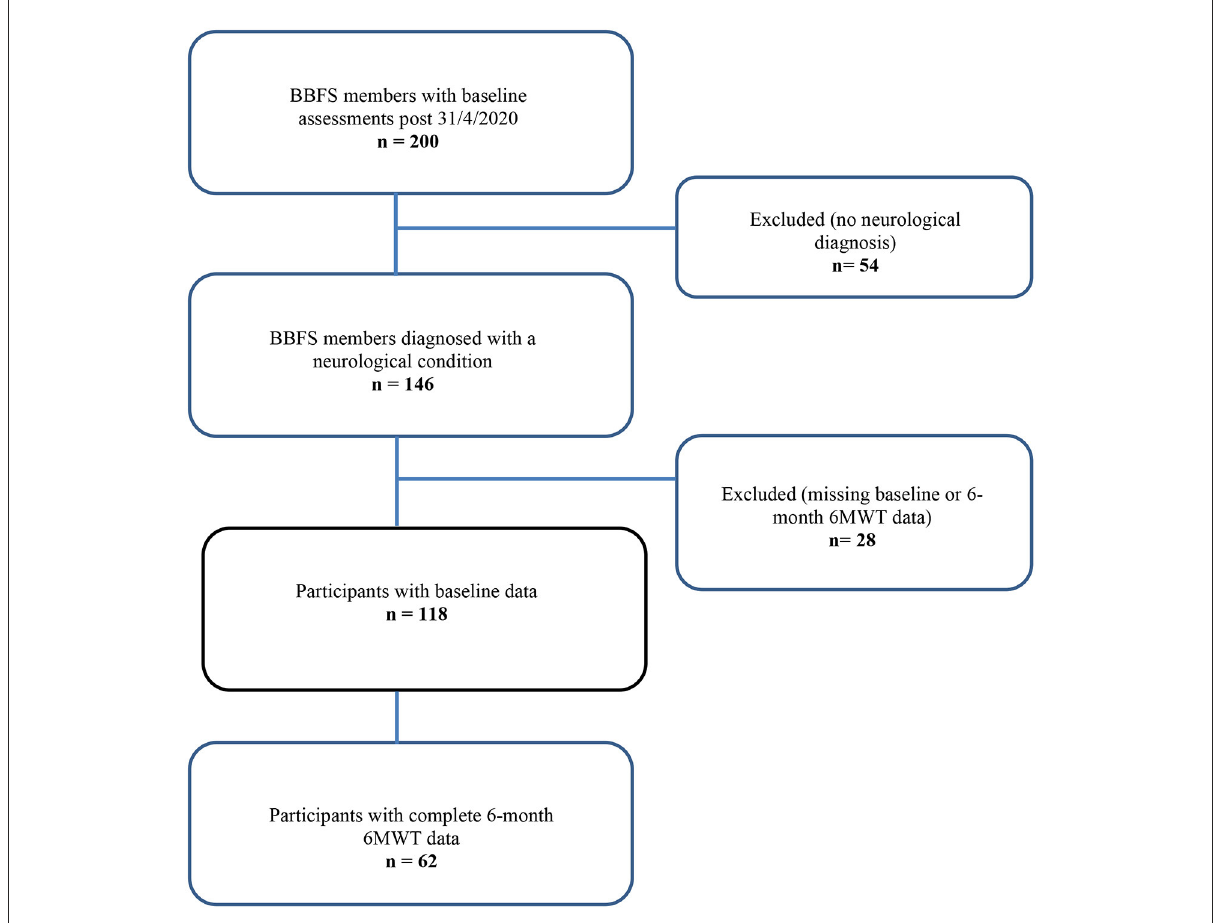
FIGURE1 A flow chart of our retrospective study